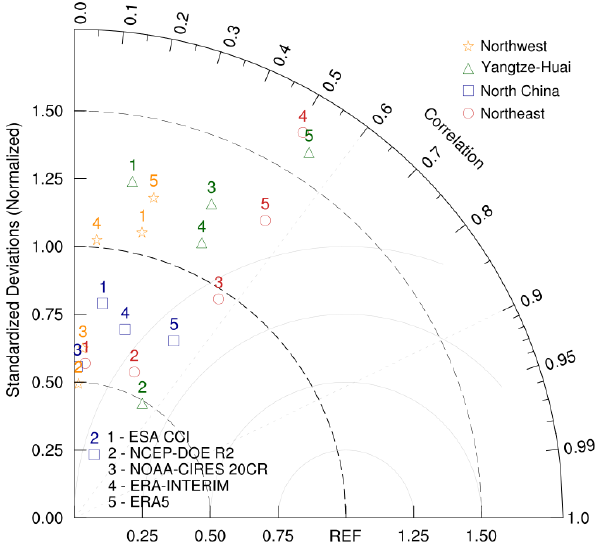
Figure 5. Taylor diagrams of the comparison between multisource SM products and in situ observations. The reference is the SM from in situ